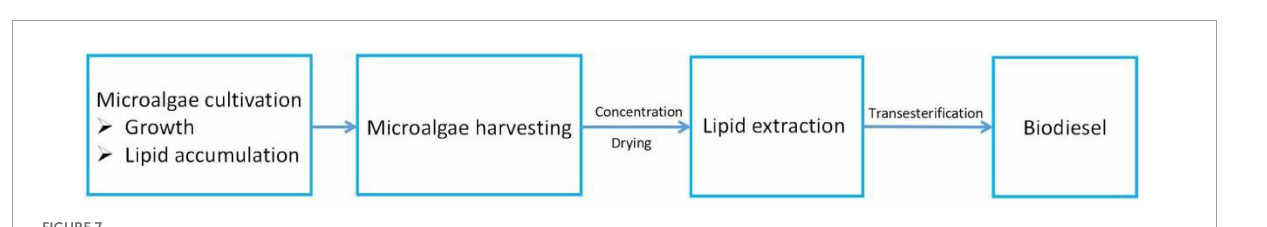
FIGURE7 Production process of microalgal